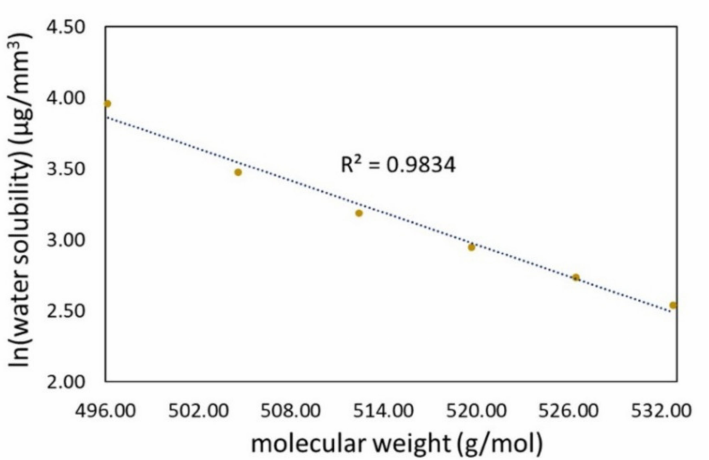
Figure 7. Correlation between the water solubility of the QA:TEG copolymers and the molecular weight of the corresponding monomer compositions. The dotted line-the trendline, the yellow points show the mean values of water